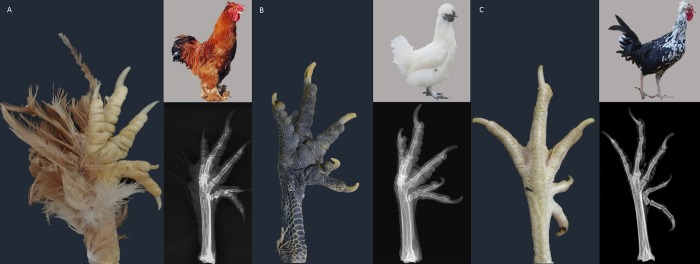
Principal polydactyly subtypes in Beijing-You, Silkie, and Houdan chickens.Two subtypes of polydactyly were found in the three chicken breeds, but with difference prevalence. Subtype I: principal subtype of Beijing-You (A) and Silkie (B), in which an extra toe was separated from the second phalanx in the most anterior toe; Subtype II: principal subtype of Houdan (C), with extra toe separation occurring from the first phalanx.